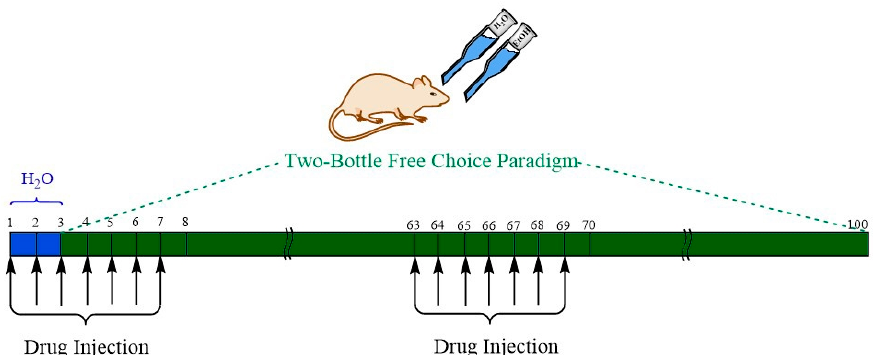
Figure 1. Arrows represent the days where UFR2709 and saline were administered, the blue square indicated the days where the drug was administered without access to ethanol, and the green timeline indicates the days where the ethanol intake protocol was